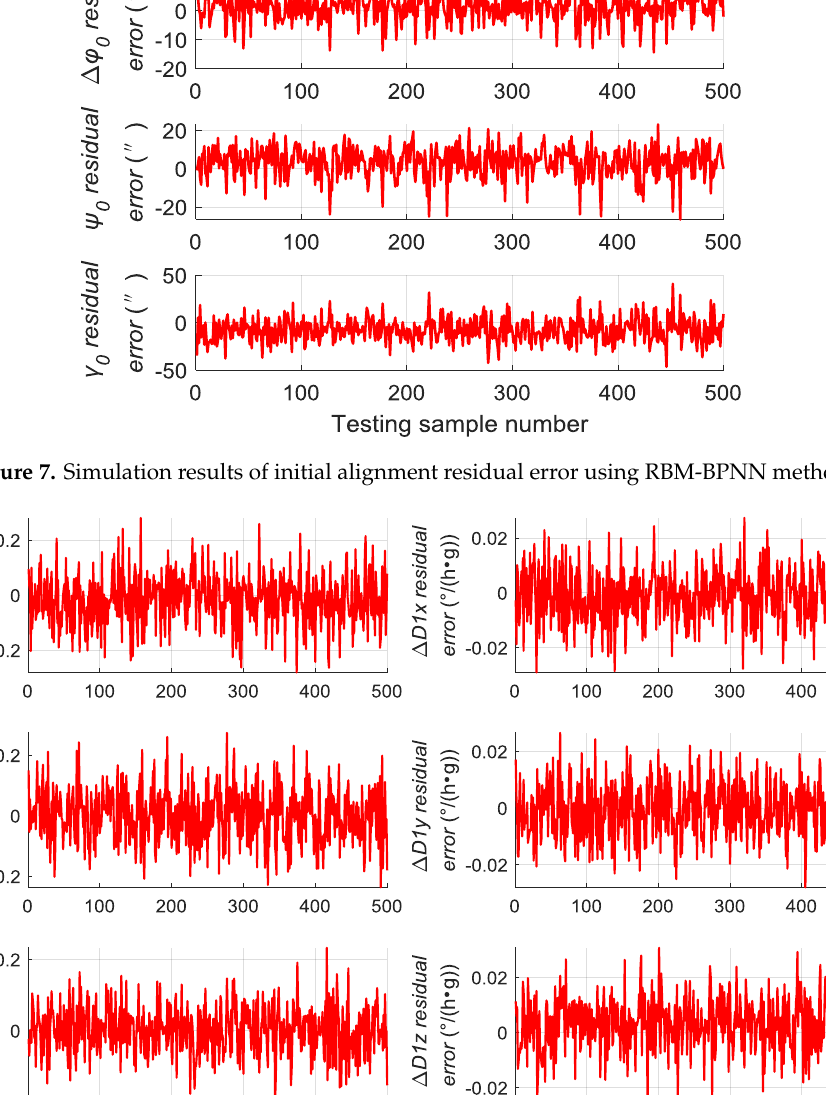
Figure 9. Simulation results of accelerometer residual error using RBM-BPNN method.